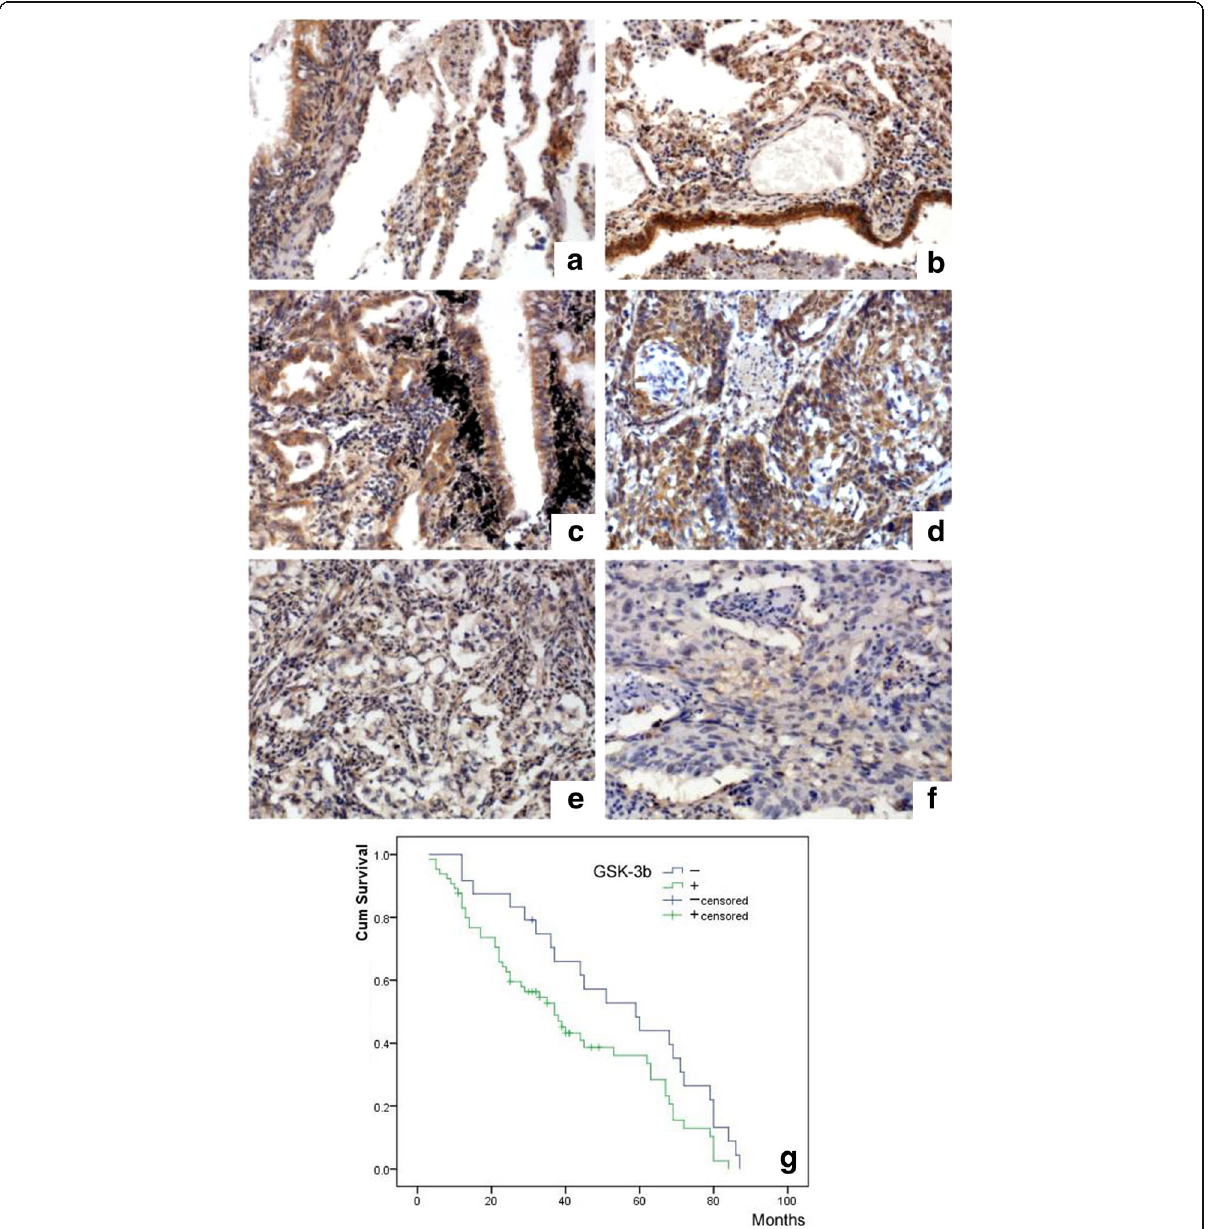
Fig. 1 GSK-3 β expression in NSCLC specimens. GSK-3 β expression was strong ( a , b ) in the bronchioles and alveoli, positive in well-differentiated NSCLC ( c , adenocarcinoma and d , squamous cell carcinoma), and weak or negative in poorly differentiated NSCLC ( e , adenocarcinoma and f , squamous cell carcinoma). A Kaplan-Meier survival analysis showed that patients with negative GSK-3 β expression had a significantly better prognosis than those with positive expression ( g